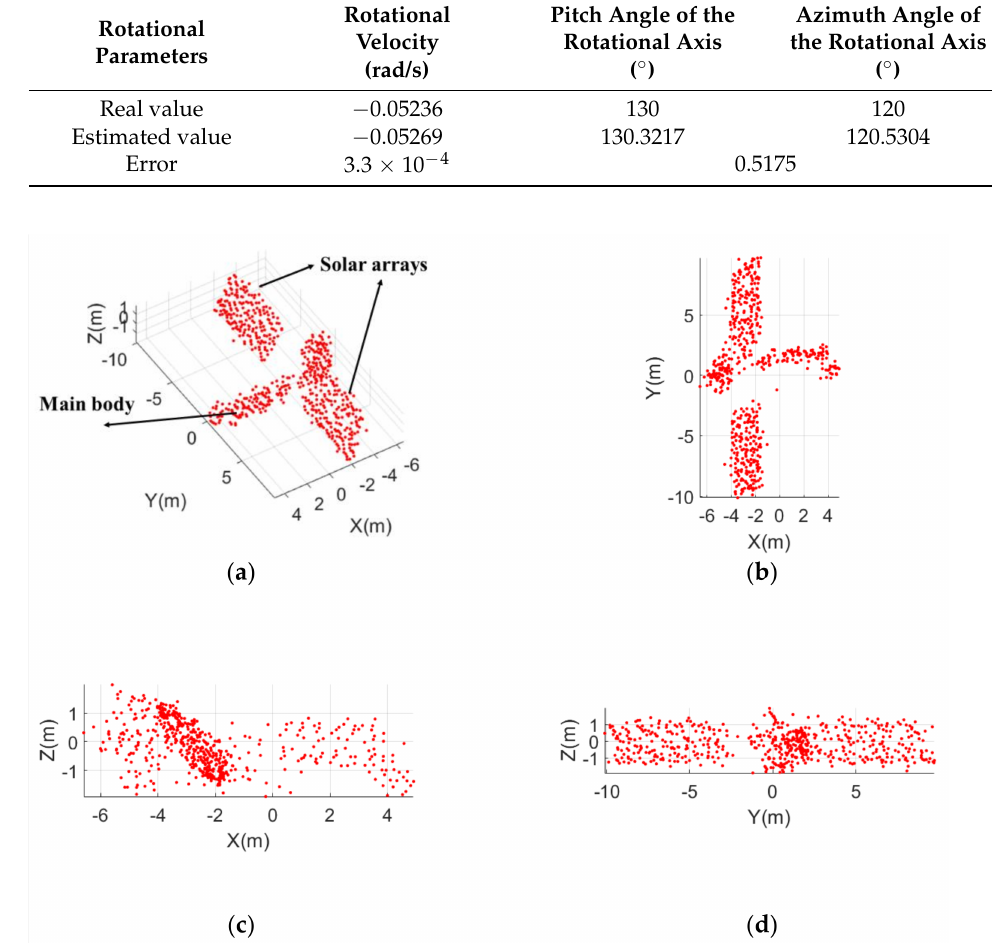
Figure 14. The reconstructed 3D point cloud of Tiangong-1: ( a ) The reconstructed 3D point cloud, ( b ), ( c ), and ( d ) top, side, and front